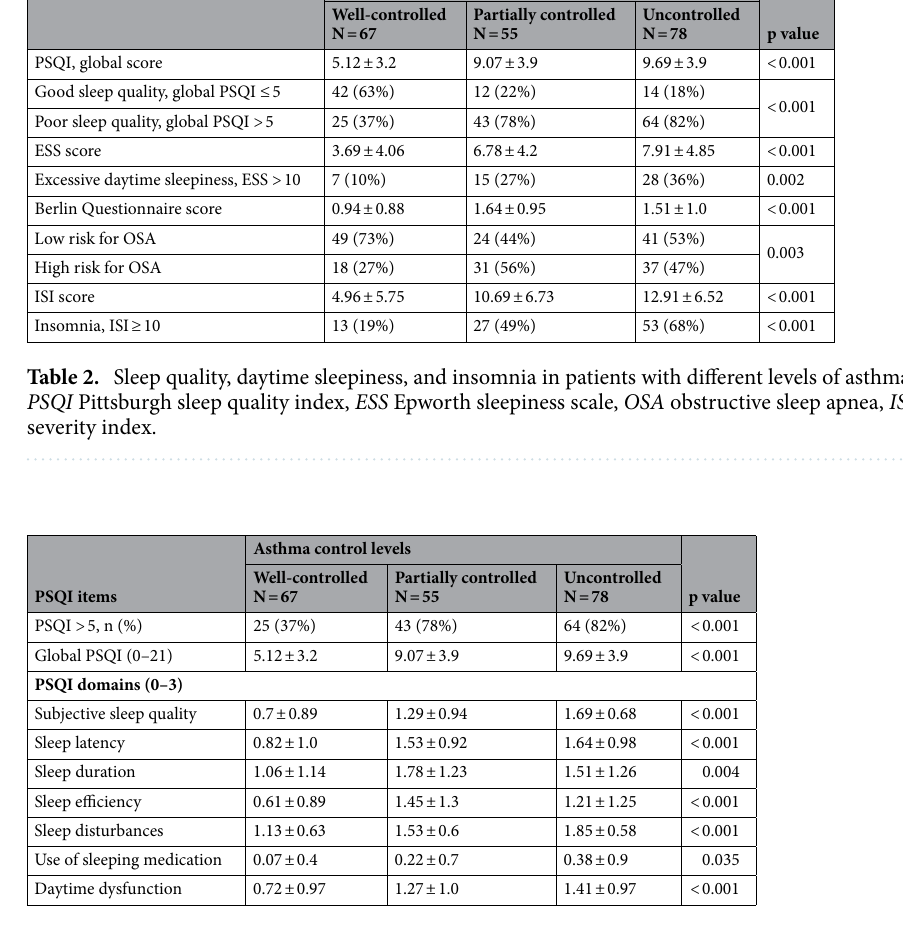
Table 3. Comparison of the Pittsburgh Sleep Quality Index (PSQI) between patients with different levels of asthma control. PSQI Pittsburgh Sleep Quality Index.